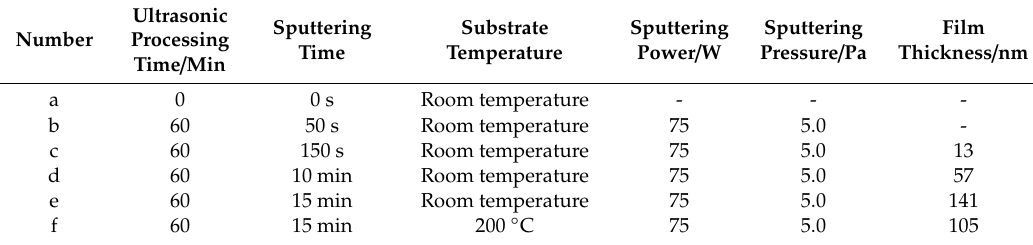
Table 1. Magnetron sputtering conditions and parameter